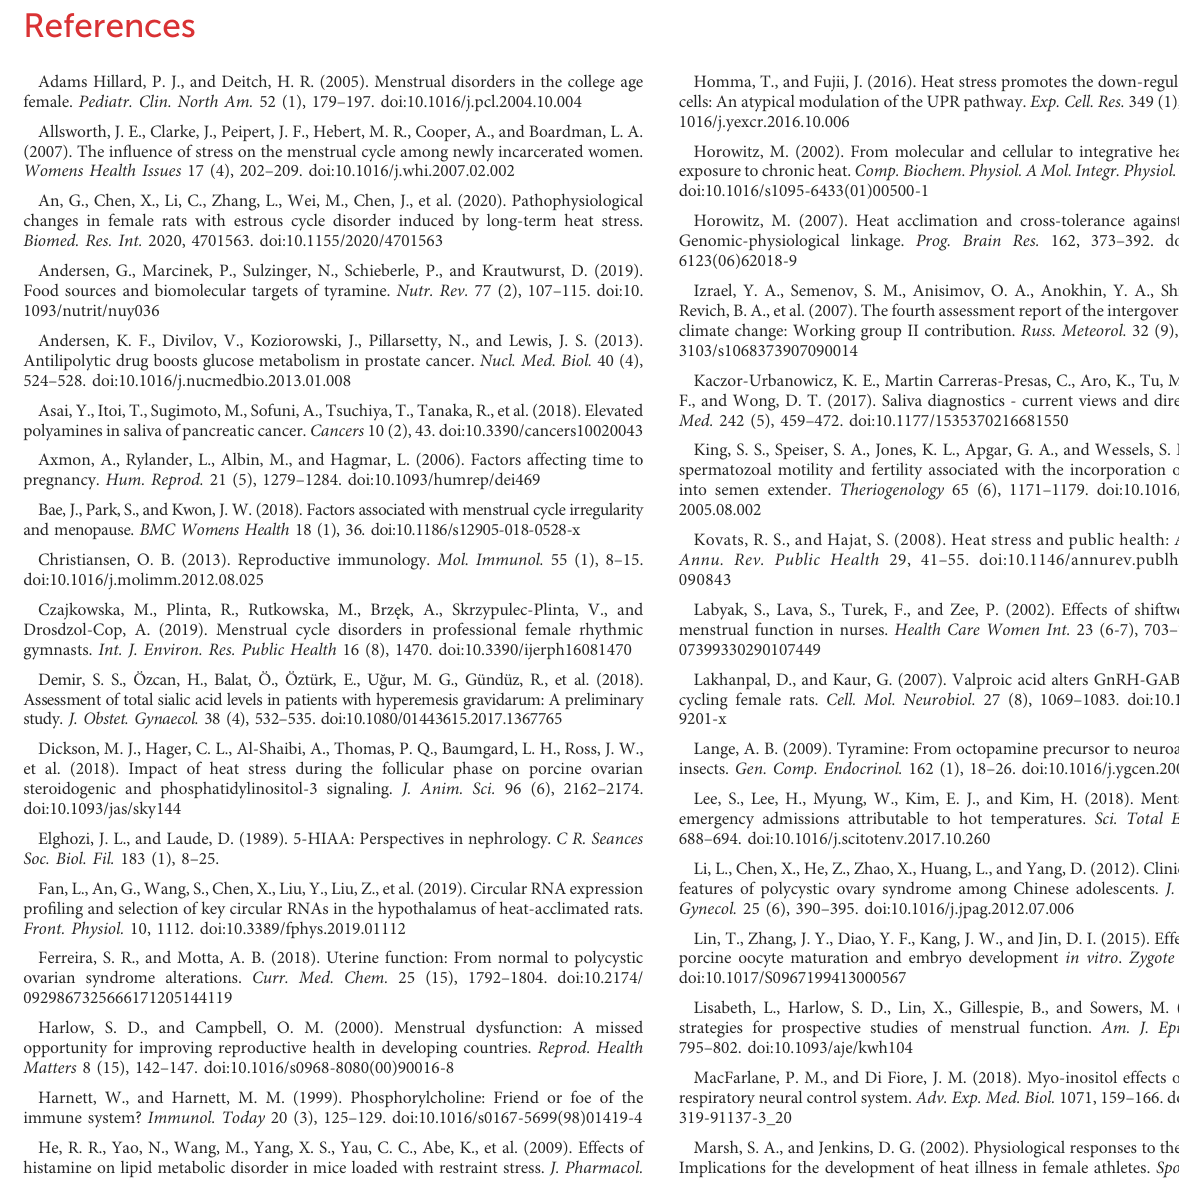
SUPPLEMENTARY TABLE S1 Metabolomics analysis date(HD-CD). SUPPLEMENTARY TABLE S2 Metabolomics analysis